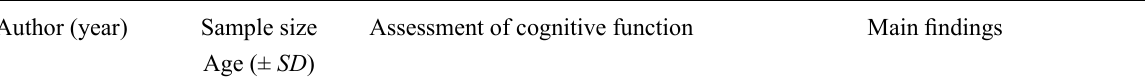
Table 1 Description of Selected Studies, Including Sample Size, Participant Age, Instruments Used for Assessment of Cognitive Function, and Main